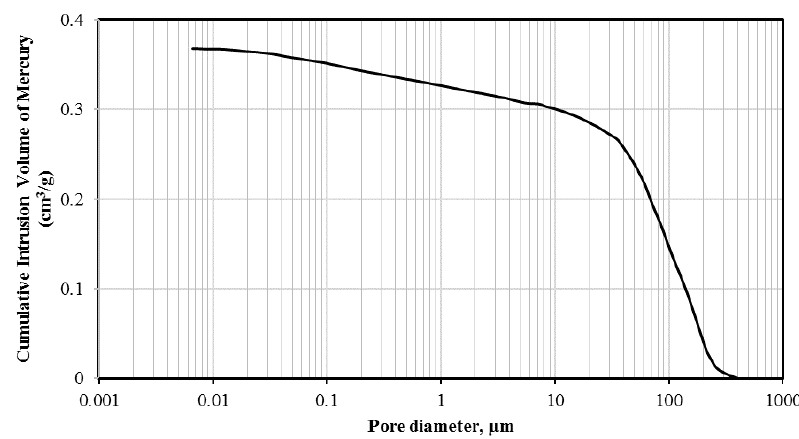
Figure 9. Pore volume of lightweight aggregate measured using MIP.